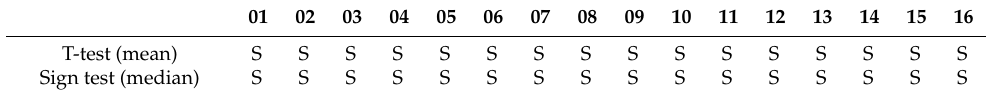
Table 8. Pair comparison of absolute rankings in both analysis